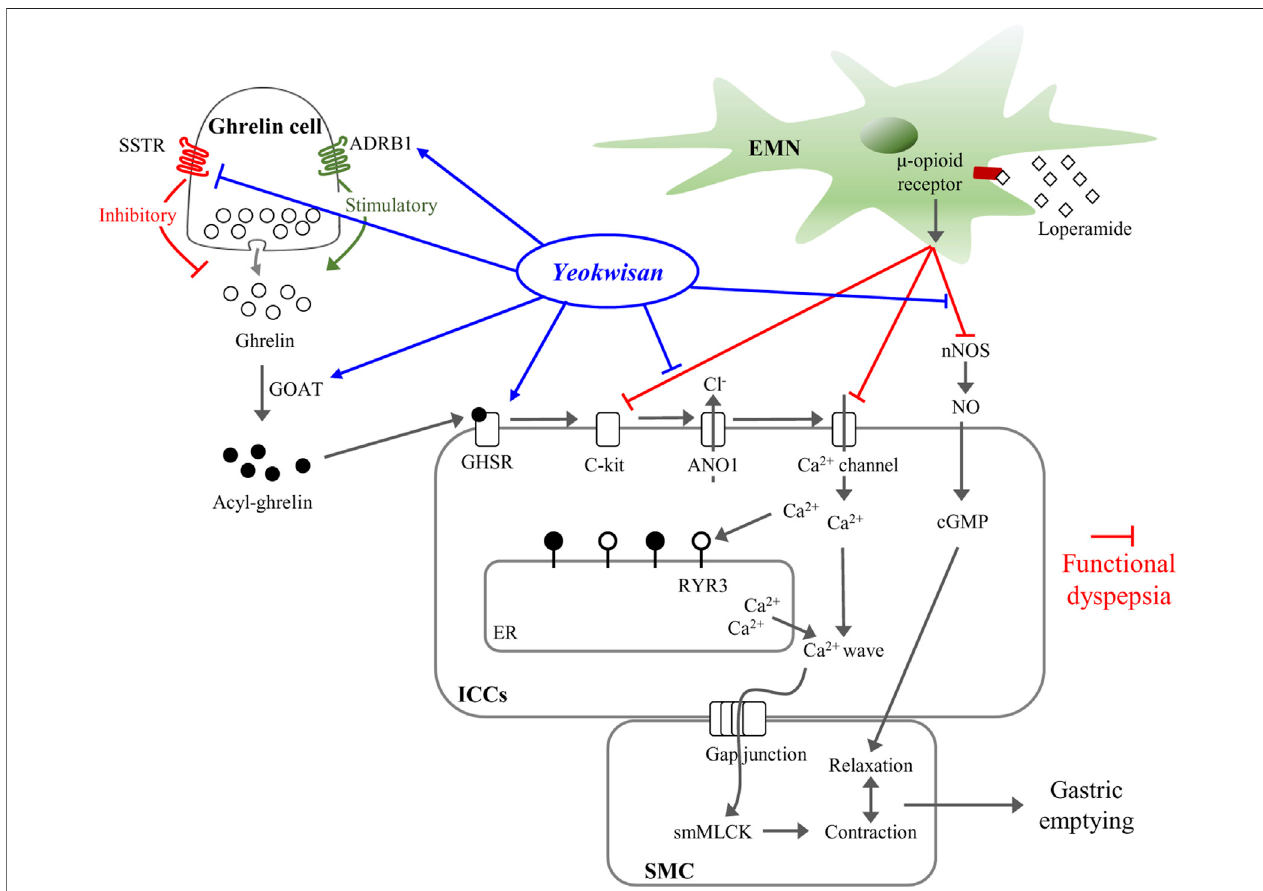
FIGURE7| Summaryformechanismof Yeokwisan onstomachtissueinloperamide-inducedfunctionaldyspepsiamodel.ADRB1,adrenergicreceptor β 1;ANO1, anoctamin-1; cGMP, cyclic guanosine monophosphate; EMN, enteric motor neuron; ER, endoplasmic reticulum; GHSR, growth hormone secretagogue receptor; GOAT,ghrelin-O-acyltransferase;ICCs,interstitialcellsofCajal;nNOS,neuronalnitricoxidesynthase;NO,nitricoxide;RYR3,ryanodinereceptor3;SSTR,somatostatin receptor; smMLCK, smooth muscle myosin light chain kinase; SMC, smooth muscle cell.